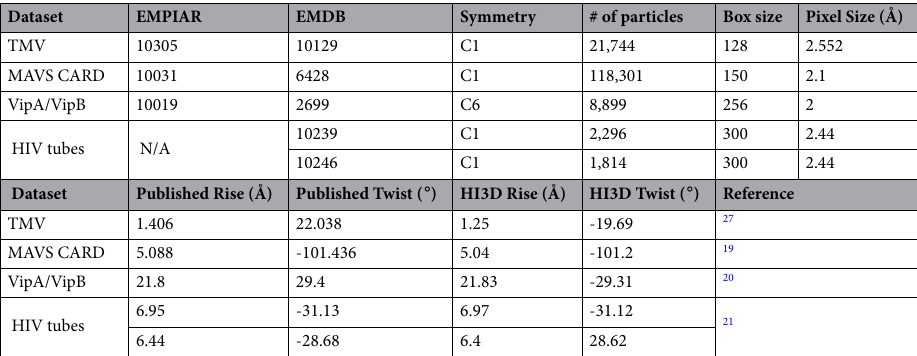
Table 1. Comparison of HI3D reported helical parameter with the published